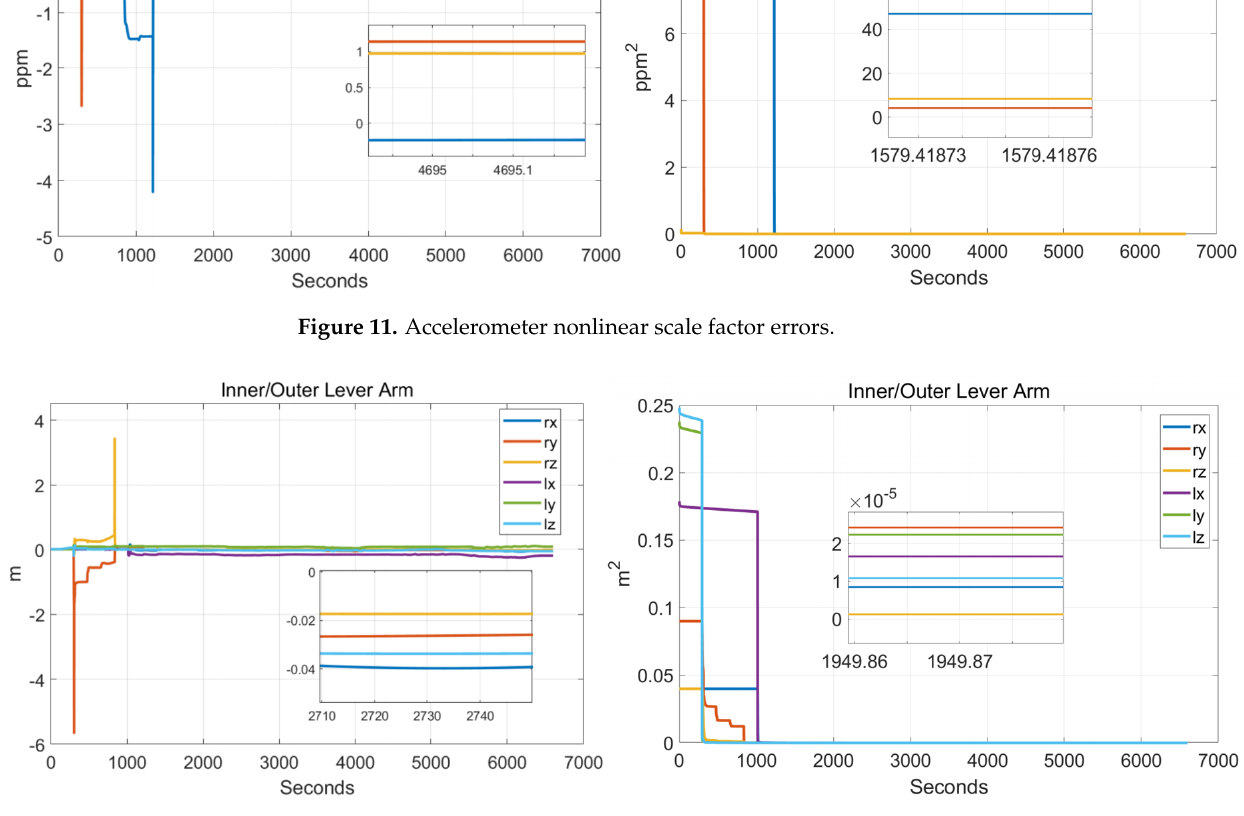
Figure 12. Inner/outer lever arms.